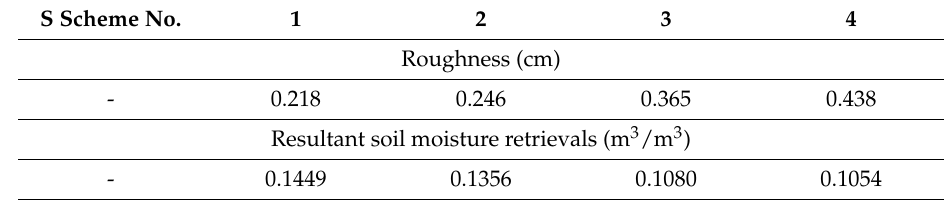
Table 2. The different spatial averages of soil moisture products by roughness schemes. S Scheme No.